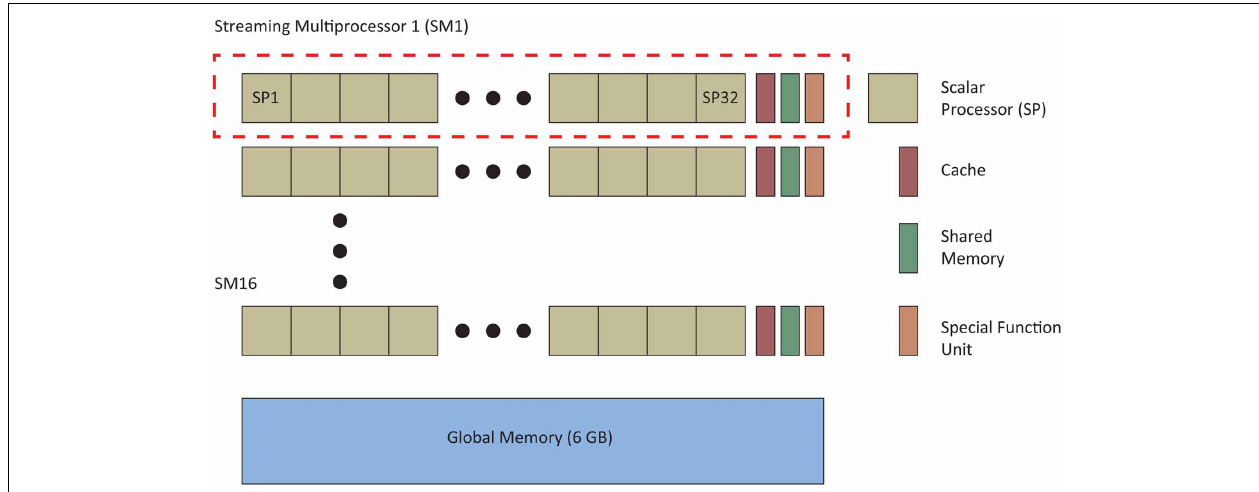
FIGURE 1 | A simplified diagram of NVIDIA CUDA GPU architecture (adapted from Nageswaran et al., 2009a,b). Our simulations used an NVIDIA Tesla 2090 GPU that had 16 streaming multiprocessors (SM) made up of 32 scalar processors (SPs) and 6GB of global memory.